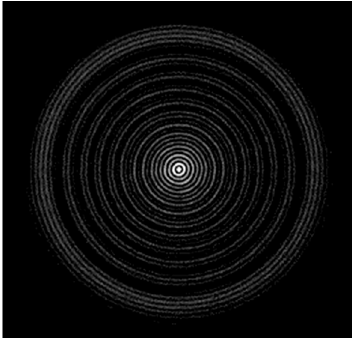
Figure 2. Typical pattern of the backscattered optical signal generated by a S-LAH79 glass sphere.